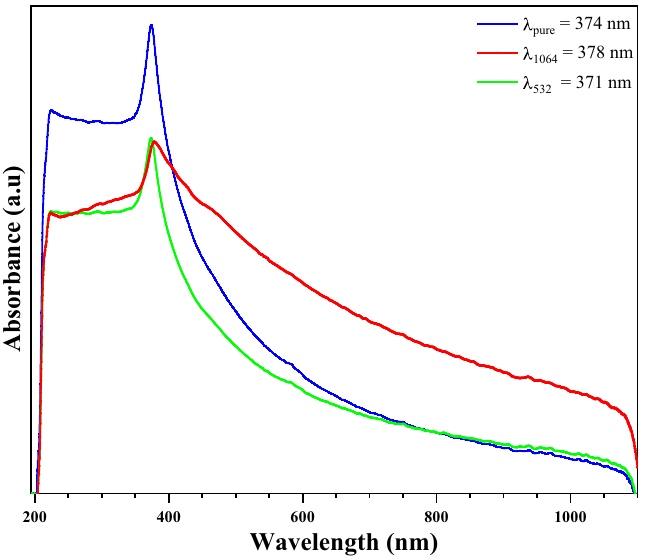
Figure 9. The spectra of the ultraviolet–visible spectroscopy measurements for the ZnO NPs before (blue line) and after irradiations (red and green